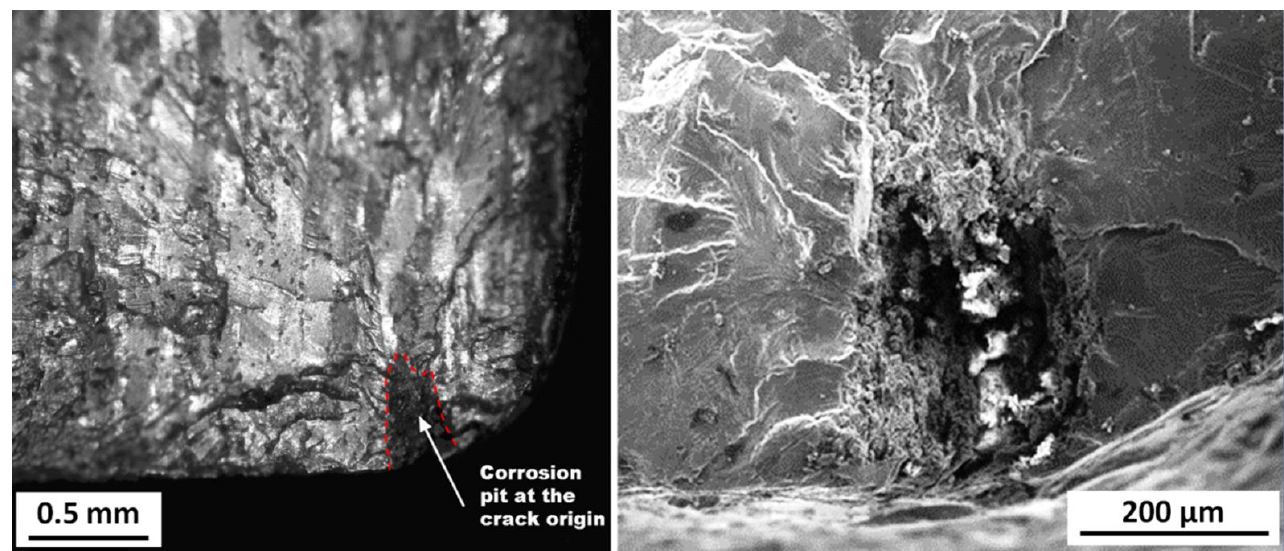
Figure 10. Optical and SEM fractographs of fatigue crack nucleation at a deep corrosion pit on the Y488 bulkhead forward mould line flange, from [15].